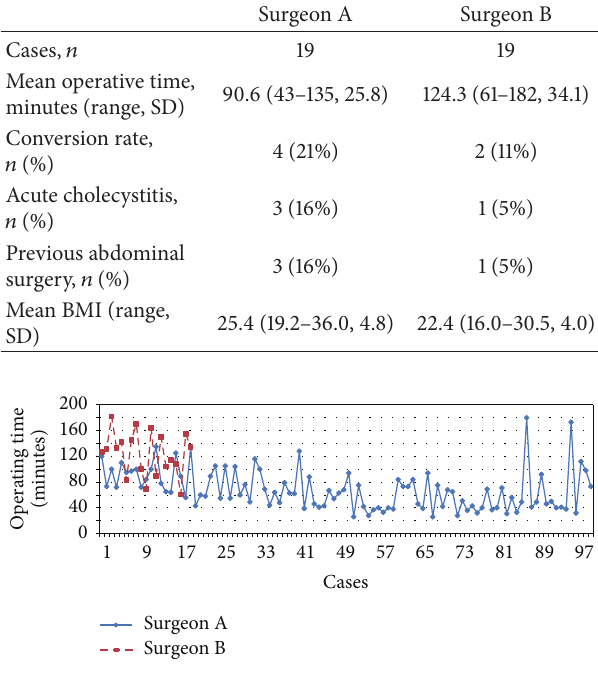
Figure 5: Operating times of Surgeons A and